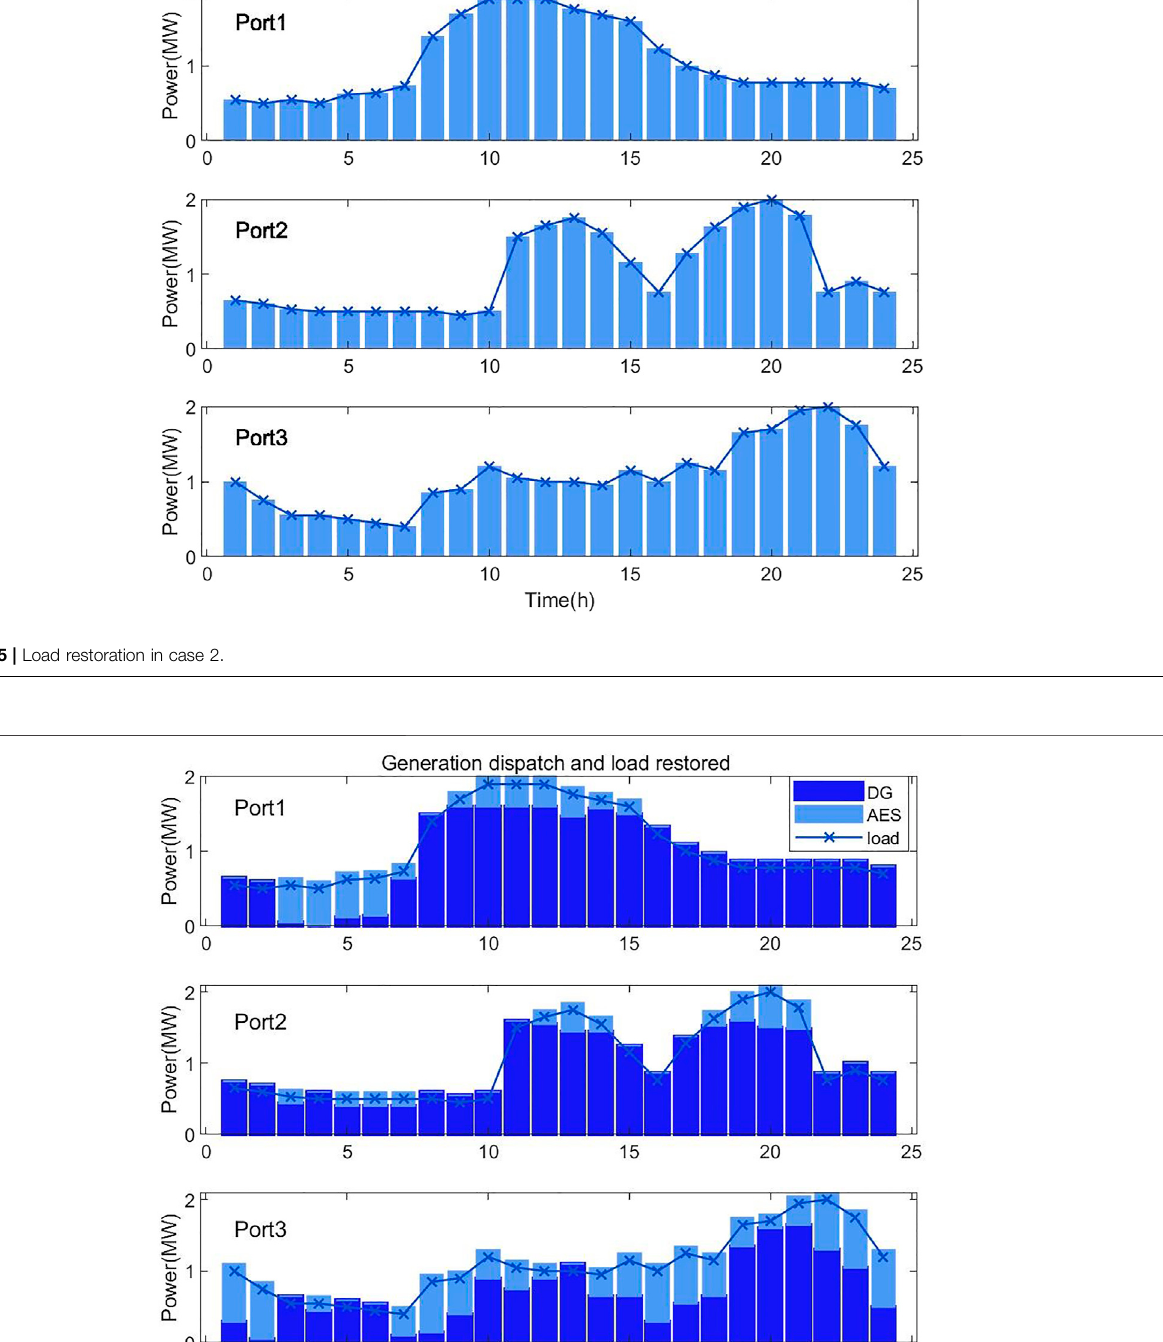
Frontiers in Energy Research |